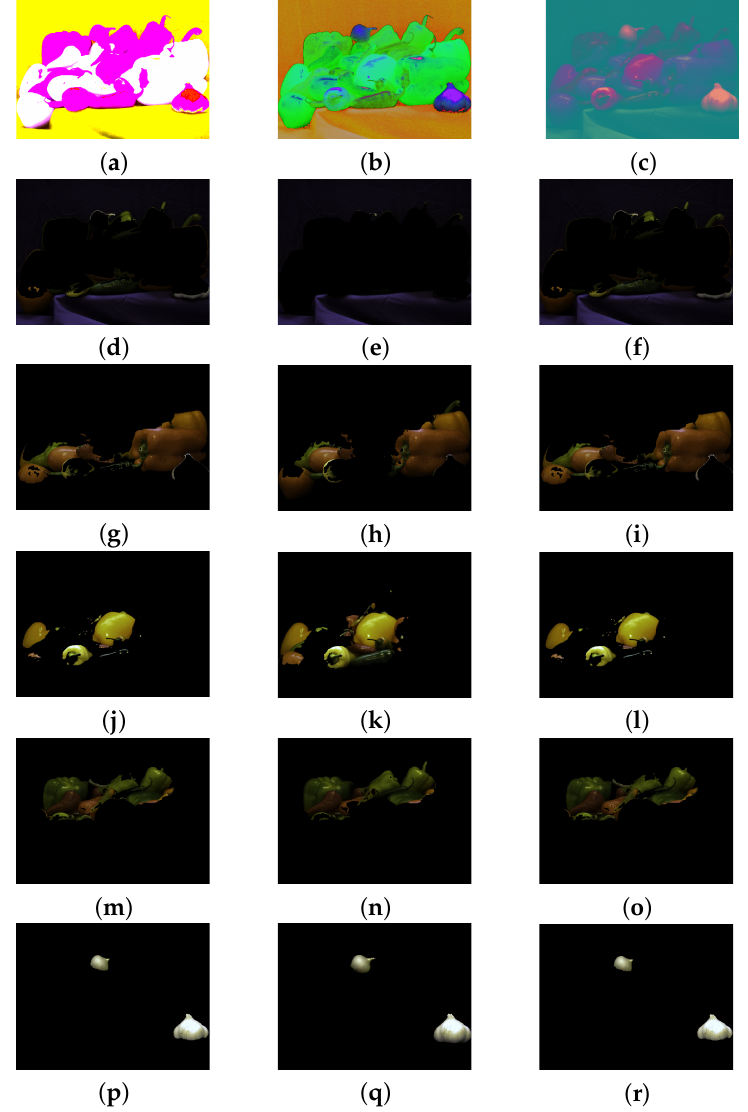
Figure 11. Performance comparison with respect to different colour spaces, Peppers image. ( a – c ) Pep- pers image in the CIELAB, HSV, YCbCr colourspaces, respectively. ( d , g , j , m , p ) segmentation result for CIELAB colourspace. ( e , h , k , n , q ) segmentation result for HSV colourspace. ( f , i , l , o , r ) segmentation result for YCbCr